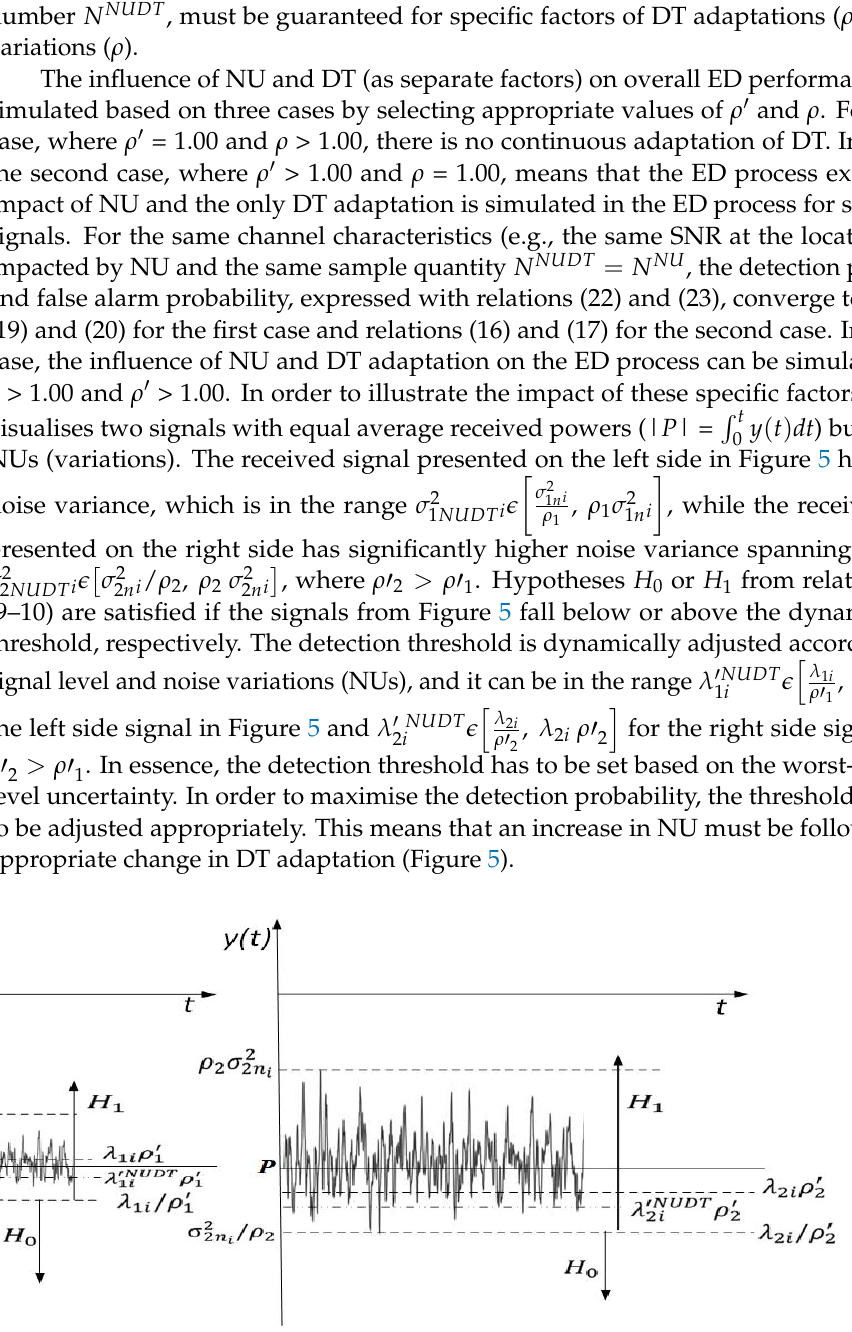
Figure 5. DT and NU ranges in the ED process of signals with equal average received power.